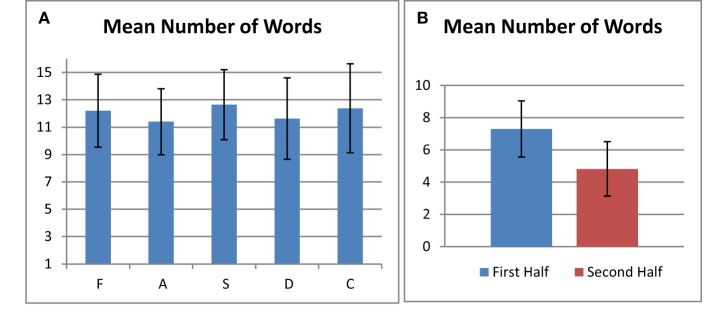
(A) Number of generated words for each letter averaged over all subjects. (B) Number of generated words in the first half and second half of the test averaged over all letters and all subjects. In both plots, error bars represent standard deviation of the mean.